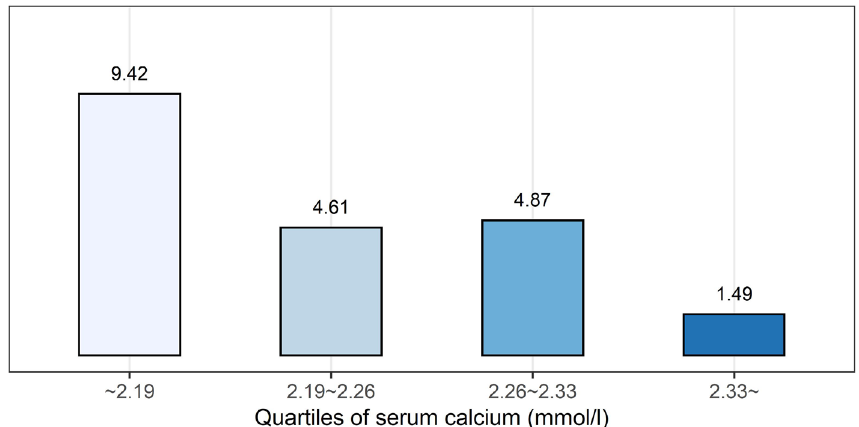
Figure 1. In-hospital mortality of patients with AMI according to the quartile of the distribution of serum calcium concentration on admission. In-hospital mortality increased with a decrease in the quartile of serum calcium concentration.